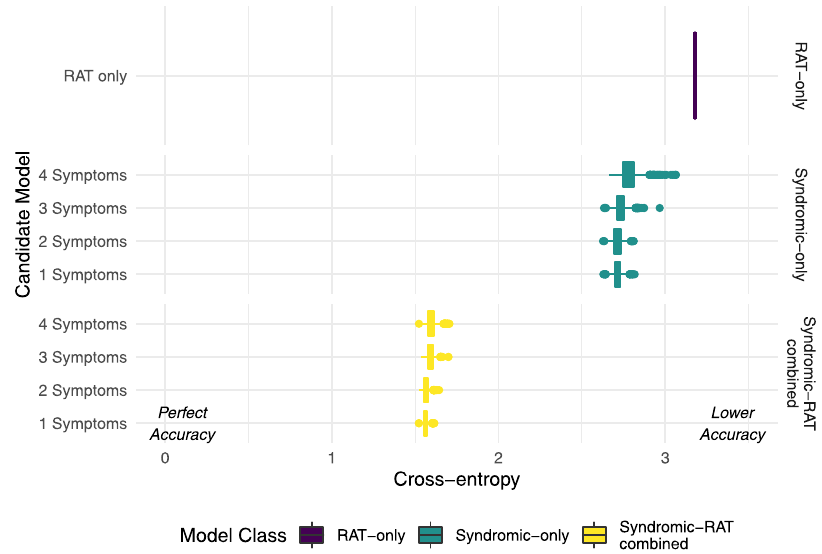
Fig. 1 Model predictive performance. Predictive performance of candidate models was measured using out-of-sample cross-entropy. Combined posterior median and interquartile ranges for n = 1172 biologically independent individuals predicted under temporally structured cross-validation. Cross-entropy shows the most generalised-level of model predictive power, assessing performance in the probability scale without requiring classi fi cation threshold decisions. A cross-entropy of zero indicates a model that predicts with certainty the correct result each time. A random classi fi er for the problem scored 11.54. Interquartile ranges are shown for the posterior cross-entropy of the best candidate models at each level of model complexity tested under temporal cross-validation. The intermediate complexity models perform best at prediction, although performance is similar across all the models within each model class. There was a marked decline in predictive power at more than four symptoms, leading us to choose this as the maximum complexity model in our candidate models. Model classes are colour-coded, the rapid antigen test only (RAT-only) model is purple, Syndromic-only model is teal, and the Syndromc-RAT Combined model is yellow.